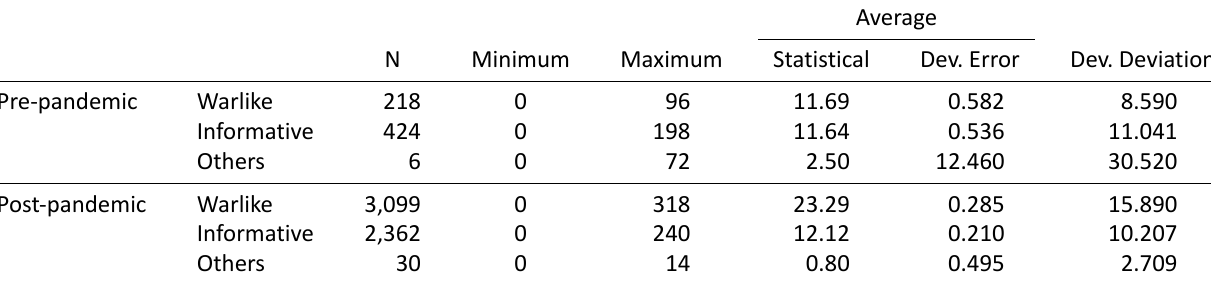
Table 5. Descriptive statistics on RQ3.